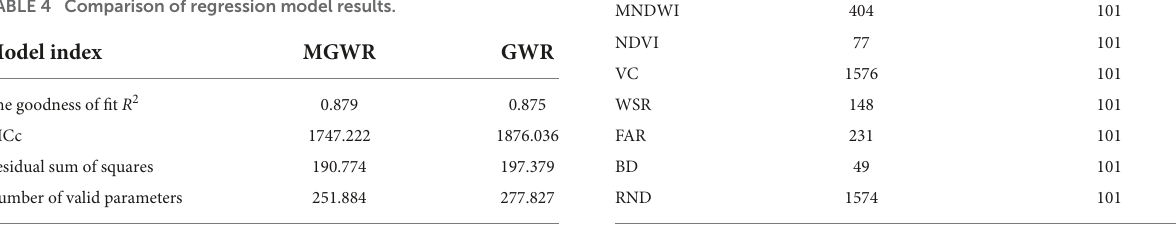
TABLE 4 Comparison of regression model